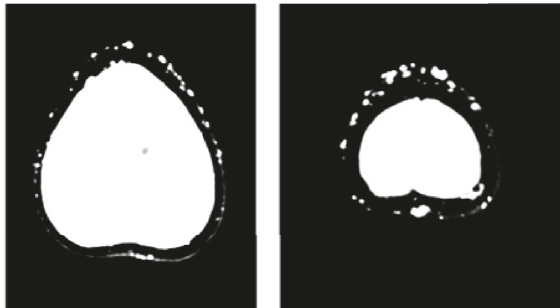
Figure 3: Extracranial subcutaneous ectopic calcifications (CT